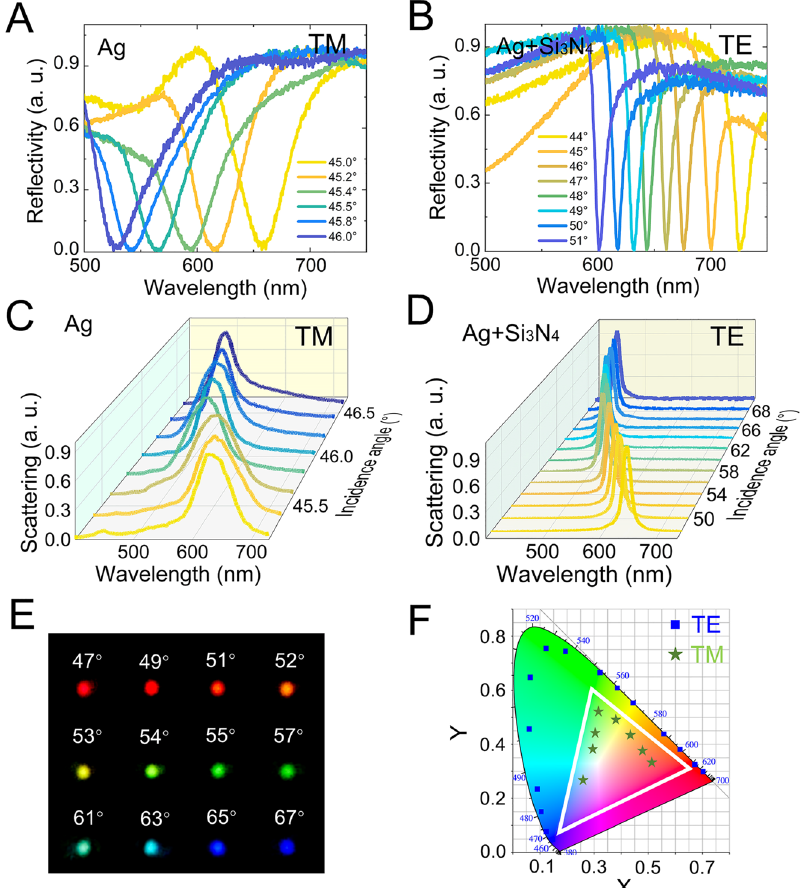
Figure 4: Reflection spectra measured for the lowest-order TM (A) and TE (B) wave excited in a Si 3 N 4 /Ag heterostructure. The thicknesses of the Si 3 N 4 layer and the Ag fi lm were designed to be 100 and 50 nm, respectively. The corresponding scattering spectra are shown in (C) and (D), respec- tively.(E)CCDimagesofthescatteringlight measured the TE waves excited at different incidence angles. (F) Chromaticity co- ordinates extracted from the scattering spectra of the TE (squares) and TM (stars) waves of the lowest-order excited at different incidence